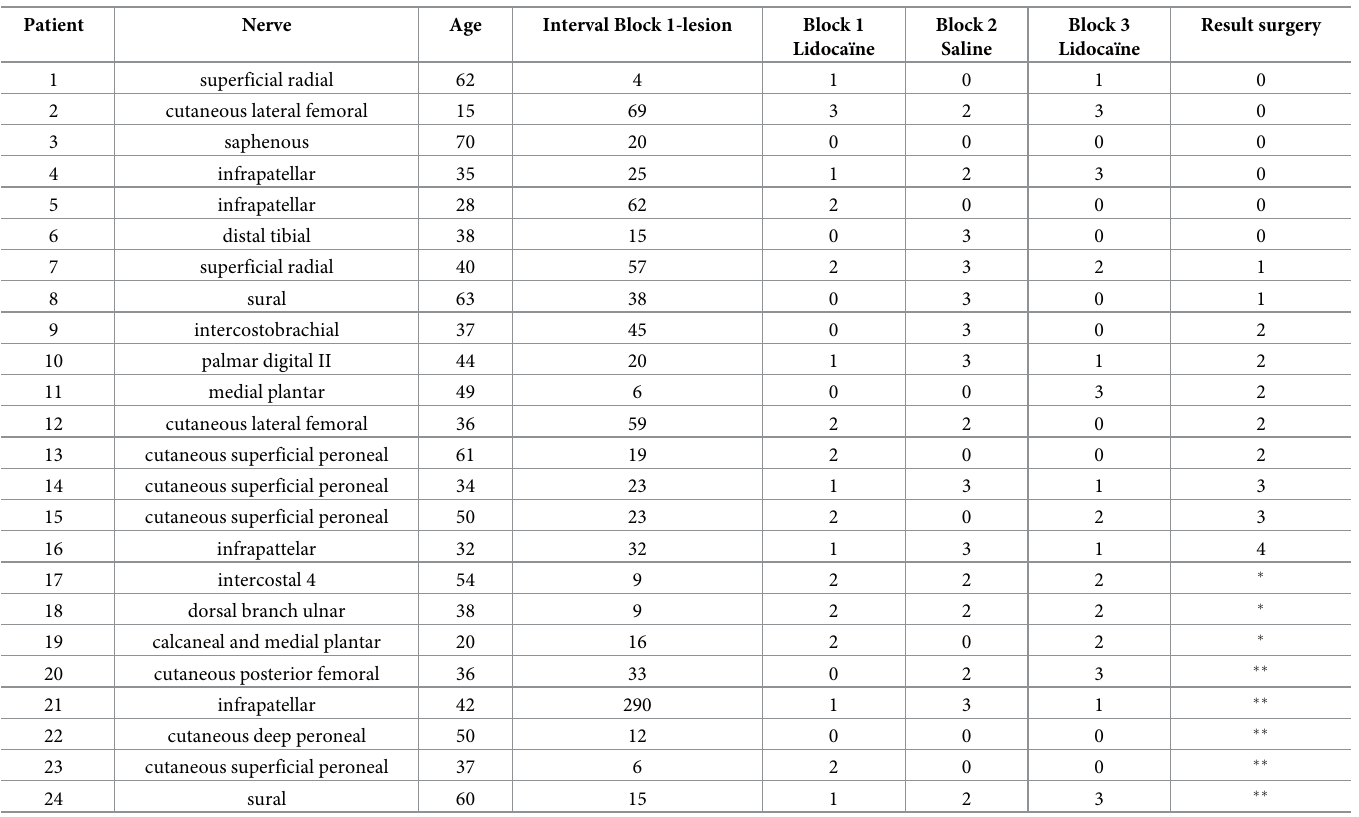
Table 1. Effect of blocks and surgery on pain.